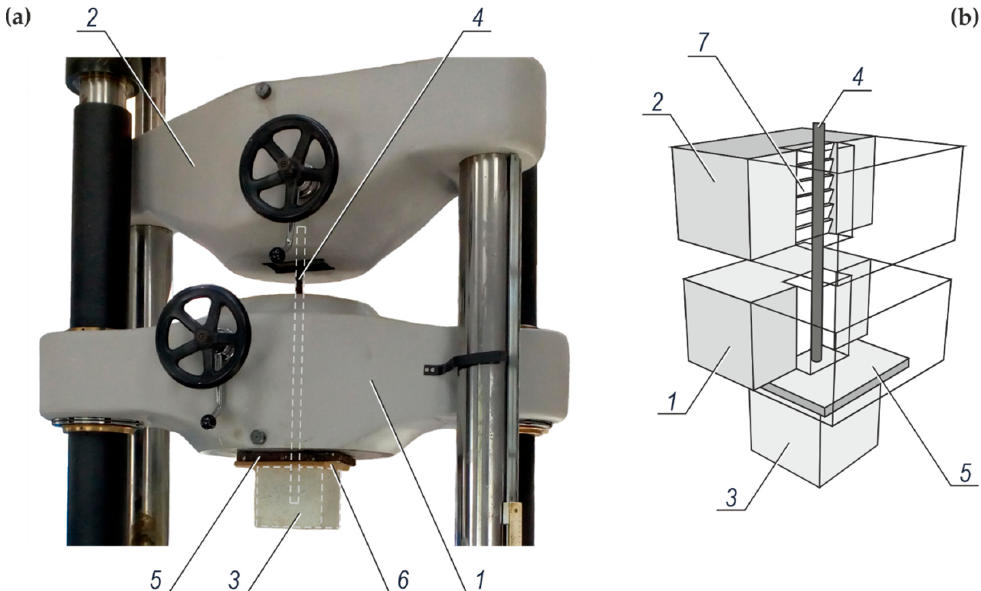
Figure 4. The test stand for testing the force pulling out the rebars from concrete: ( a ) view of the test machine from the Labortech company (Opava, Czech Republic) during the tests, ( b ) a diagram of the test system; 1 —a bottom holder of the test machine, 2 —a top holder of the test machine, 3 —a concrete specimen being a part of the test element, 4 —a rebar placed between holders and pulled out from the concrete specimen, 5 —steel slab transmitting force to the concrete specimen, 6 —equalizing washer made of HDF (high-density fibreboard), 7 —convergent self-clamping grips of the top holder of the test